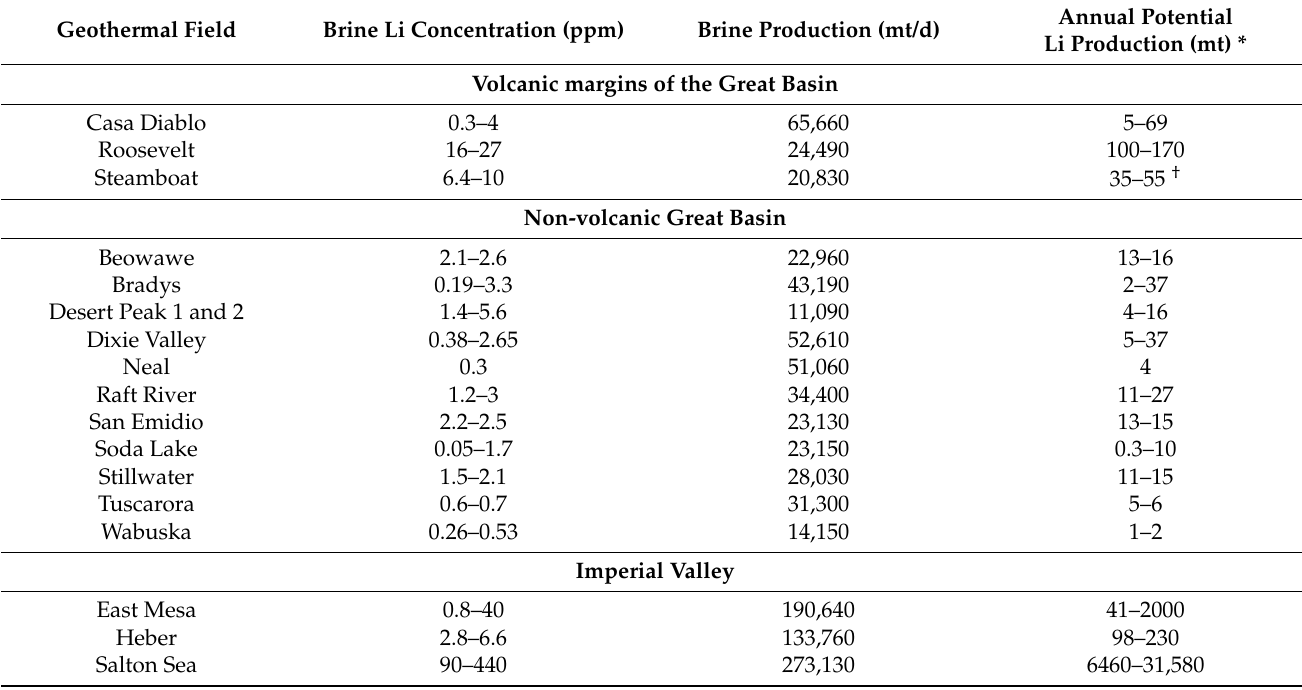
Table 3. Lithium concentrations and potential lithium (as Li) production from selected operating geothermal fields in the US (adapted from Neupane and Wendt